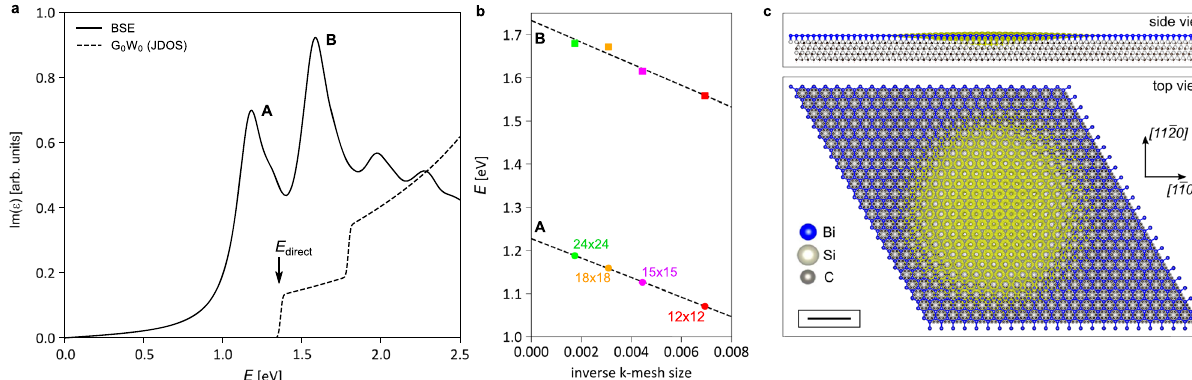
A and B exciton peaks as a function of the inverse of the number of k -points. The intersection ofthe graydashedline withthe y -axis givesthe result ideallyobtained from an in fi nitely dense k -mesh. c Lateral and top views of the A exciton wave- function. The radius of the exciton is